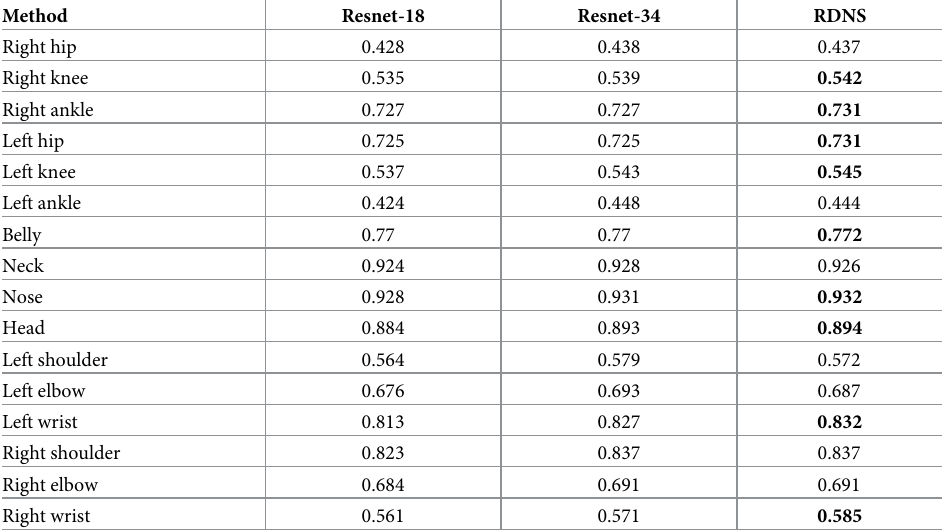
Table 3. The JDR (%) results of each joint on the MPII dataset. The better results in our method are written in bold.